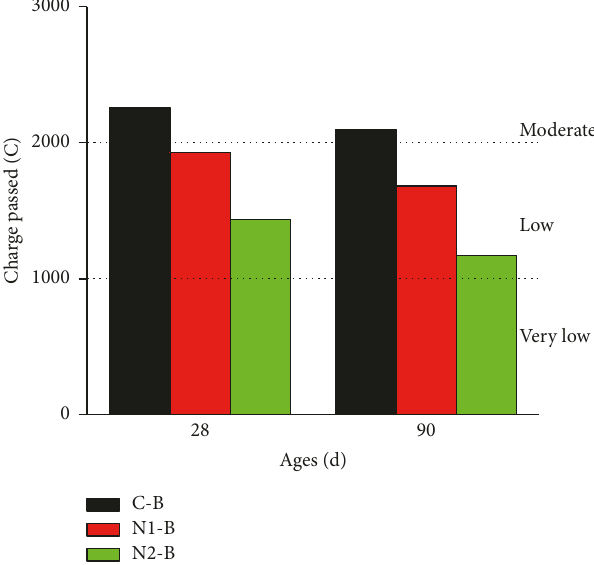
Figure 20: Compressive strength of the steam-cured concrete with W/B of 0.4.